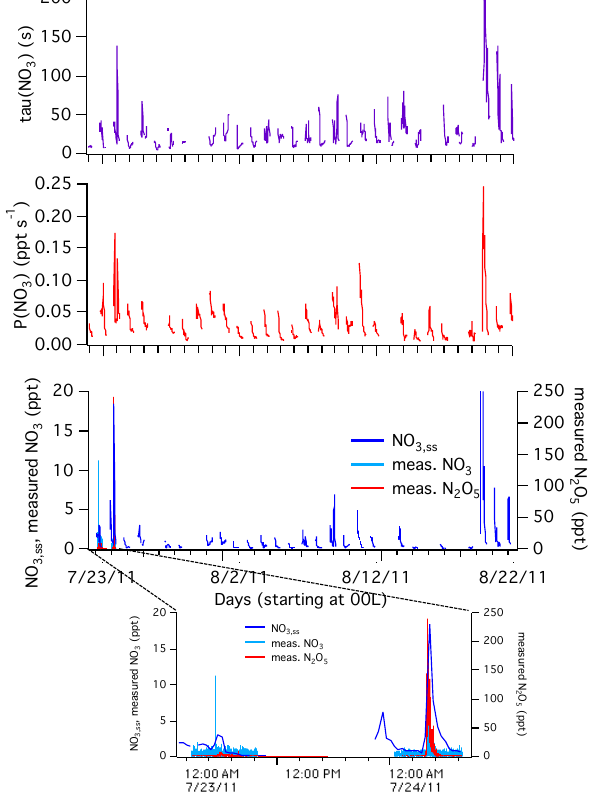
Fig. 7. Calculated lifetime based on BVOC reactive losses (top, purple), production rate from NO 2 + O 3 (middle, red) and pre- dicted steady-state concentration (lower, blue) of NO 3 throughout the RoMBAS campaign, nights only. Lower panel also shows mea- sured NO 3 (aqua) and N 2 O 5 (red) from two nights early in the cam-